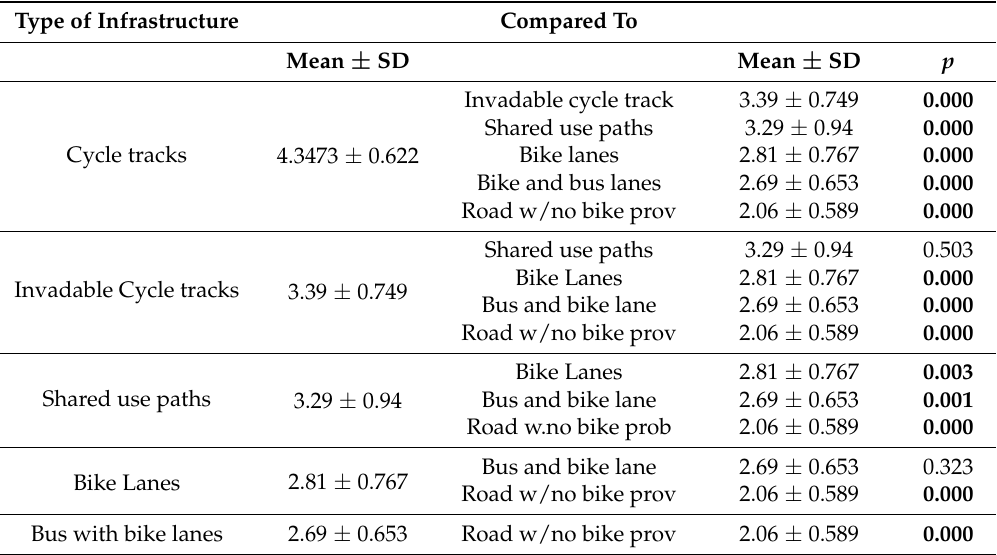
Table 3. Overall ranking means given to the images, by type of infrastructure. Comparisons between groups of images (Phase